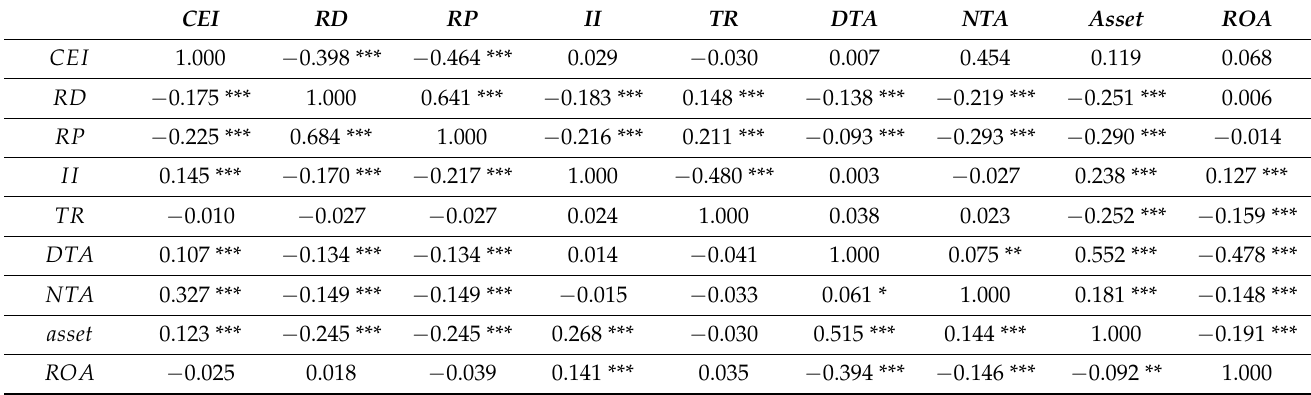
Table 4. Spearman and Pearson correlation coefficient test.